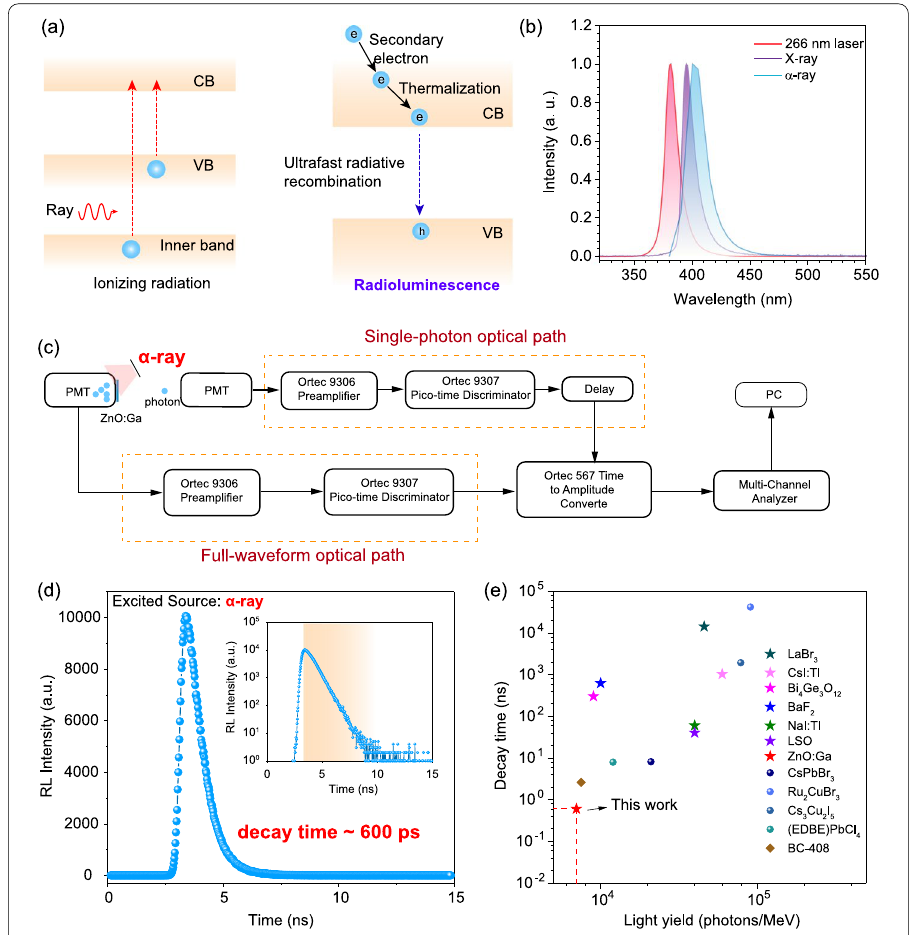
Fig. 2 Ultrafast radioluminescence of ZnO:Ga single crystal. a Schematic diagram of radioluminescence mechanism of ZnO:Ga single crystal. CB and VB denote the conduction band and valence band. e and h are electron and hole. b Spectra of the ZnO:Ga under various excitations show that obvious redshift with excited energy. c Schematic diagram of time-resolved radioluminescence measurement. d Single-particle time-resolved spectrum of ZnO:Ga excited by alpha particles. Its illustration corresponds to the logarithmic form of luminous waveform. e Reported decay time of various scintillators